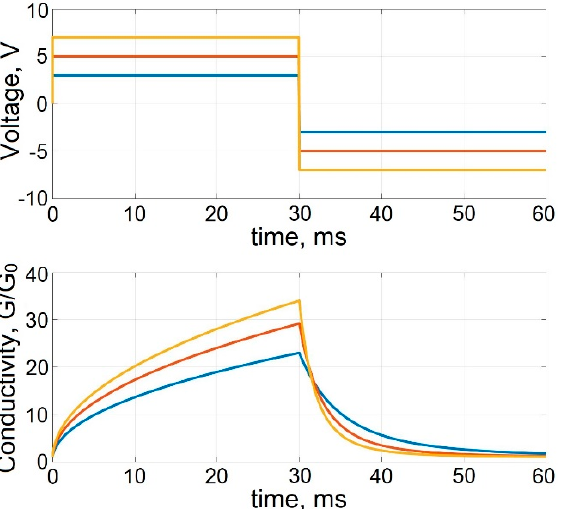
Figure 6. Transients of cyclic bipolar switching of memristive element taking into account the variability of parameters at D P = 0.1. Table 2. Model parameters for a memristor with the structure shown in Figure 2b.